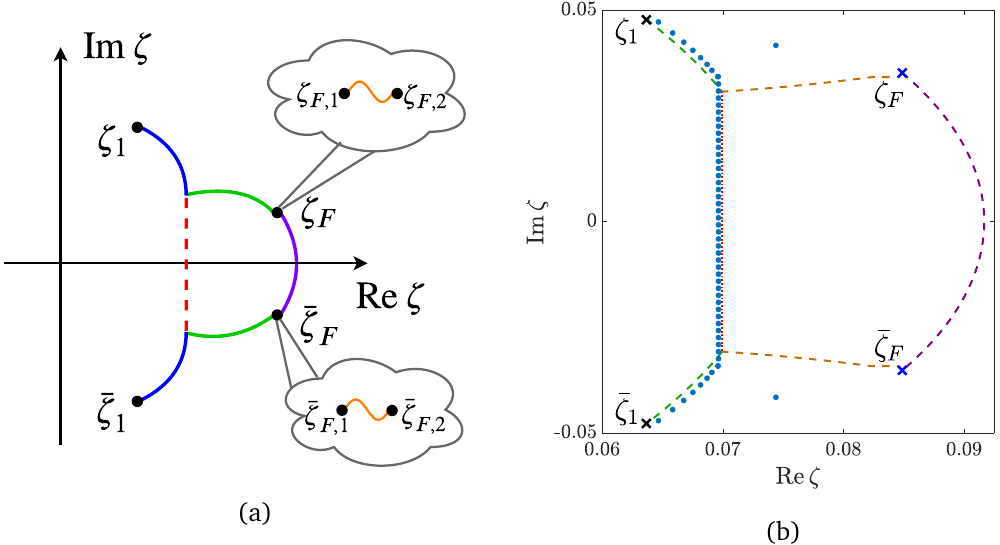
Figure 8: (Left) Complex fluctuation points ζ and ¯ ζ . They can be seen as collapsed F F → ζ → ζ → ¯ ζ → ¯ ζ cuts of a three-cut solution with ζ and ¯ ζ . (Right) F ,1 F ,2 F F ,1 F ,2 F Comparison between the classical density contour (dashed line), including with the condensate (red dashed line) and the additional contours emanating from fluctua- tion points ζ and ¯ ζ (brown and purple dashed lines), obtained from reality condi- F F tion (6.3) for the case of isotropic interaction ( δ = 0), with filling fraction ν = 0.1 and mode number n = 2, to the corresponding solution to Bethe equations (3.3) with M = 60, L = 600 and η = 0. The Bethe roots ζ (blue dots) are rescaled by the j = 1 / ( L λ ) , where λ system size L and plotted in the inverse spectral plane, i.e. ζ j j j (cid:16) λ (cid:17) L + i / 2 λ − λ + i = (cid:81) M j j k solve the isotropic Bethe equations, λ − λ − i λ − i / 2 k (cid:54) = j j k j